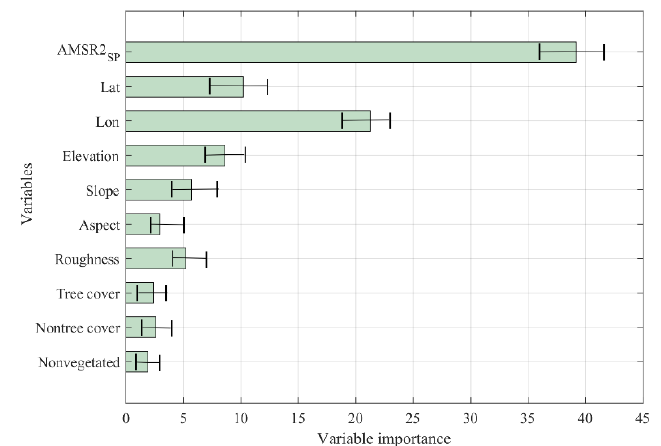
Figure 8. The ranking of variable importance for the RF-based multifactor SD downscaling model. The horizontal bars represent the variable importance scores.